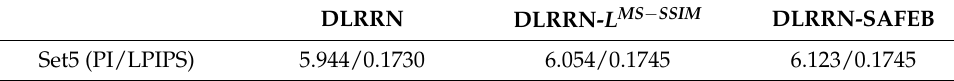
Figure 9. ( a ) SR images generated only by L1 loss function training. ( b ) SR image generated by L1 and MS-SSIM joint loss function training. Table 4. Ablation analysis of SAFEB.